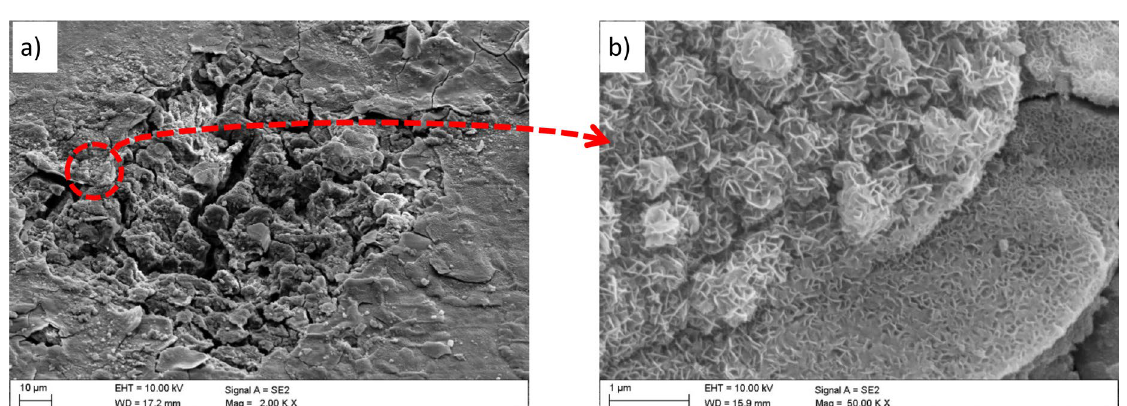
Figure 13. ( a ) Surface morphology of Ti + TiO 2 /Al 2 O 3 + TiO 2 coating on the LAE442 alloy substrate after the corrosion process, ( b ) view of crystallised magnesium oxides on the surface of the coating near the corrosion